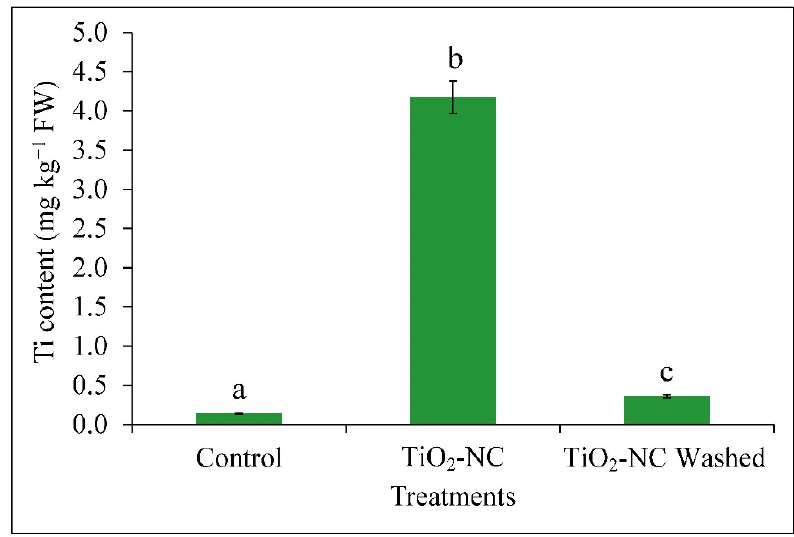
Figure 3. Absorption of Ti in Capsicum fruit recorded from 7 d TiO 2 -NC treatment and 7 d TiO 2 -NC washed with respect to control on 7 d storage under 25 °C. Vertical bars showing SE ± 1 ( n = 3) on each column and letters above bars indicate statistical variations between treatments based on one way ANOVA ( p ≤ 0.05).